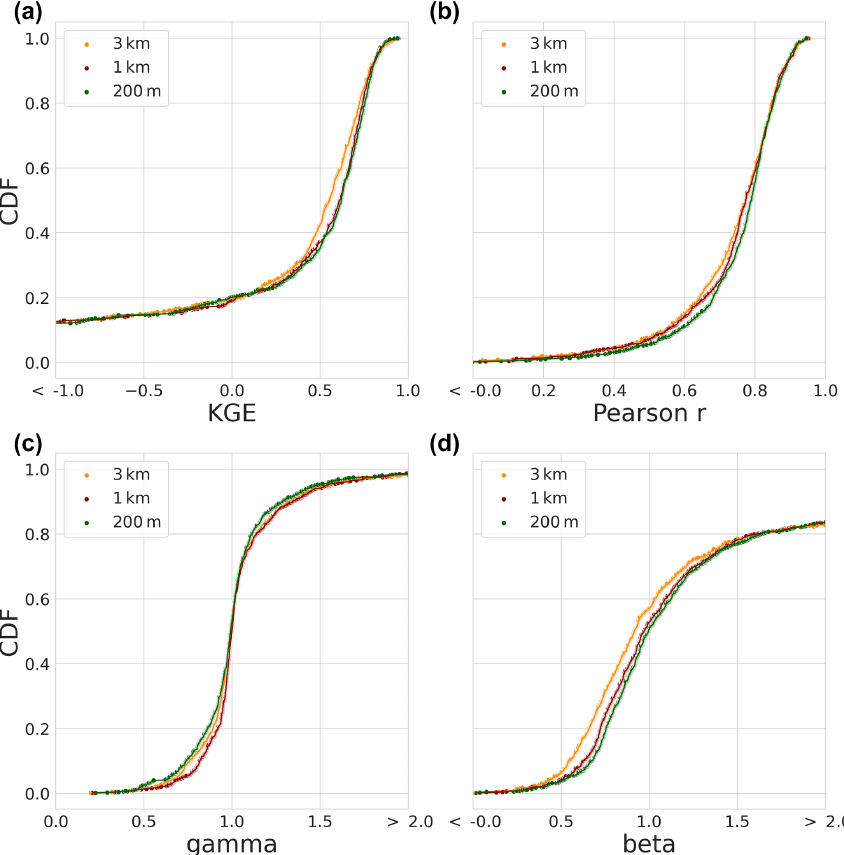
Figure 4. Calibration period results – the modified KGE score CDFs of the best-performing model runs during the calibration period and its individual components of the three model instances, i.e. 3km (orange), 1km (red), and 200m (green) model instances. (a) The CDF of the modified KGE score. (b) The CDF of the Pearson r correlation component. (c) The CDF of the gamma (variability ratio) component. (d) The CDF of the beta (bias ratio) component.